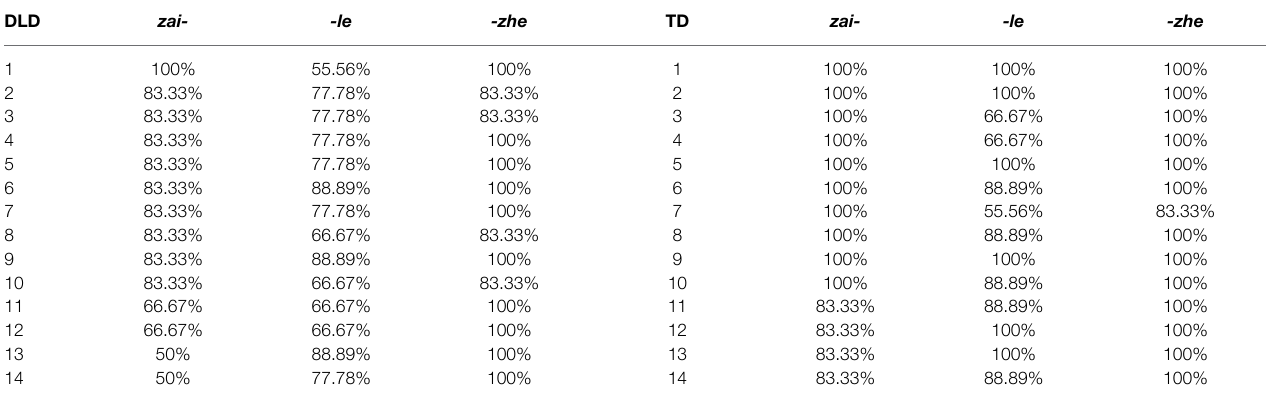
TABLE 6 | Individual performance on each aspect